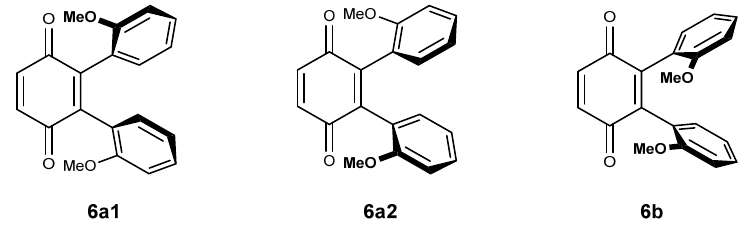
Figure 2. Structures and molecular models for compounds 6a and 6b .